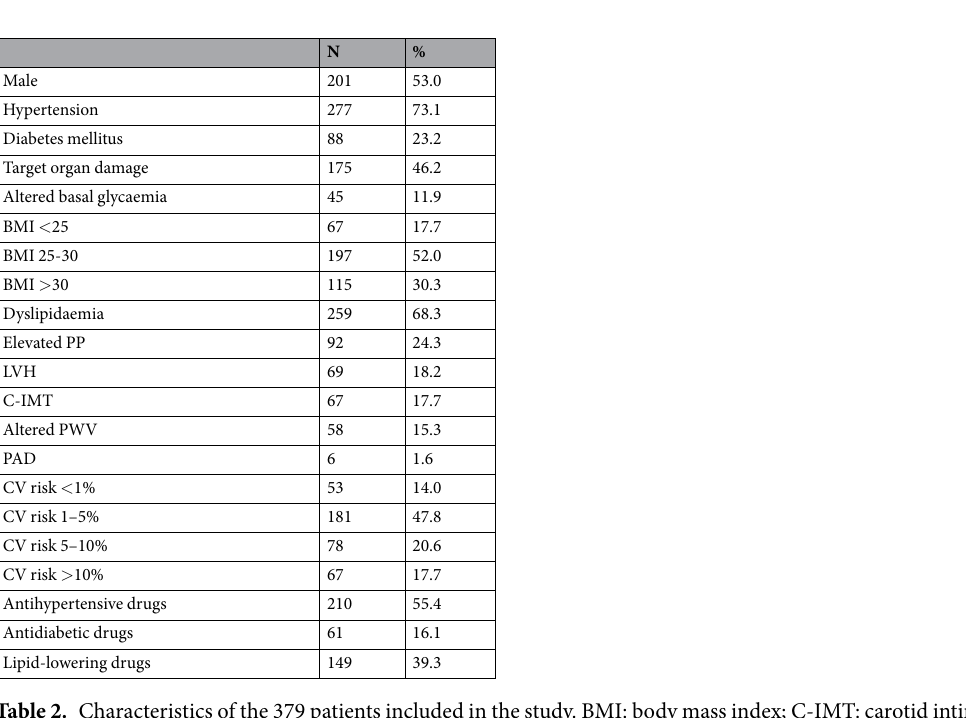
Table 2. Characteristics of the 379 patients included in the study. BMI: body mass index; C-IMT: carotid intima media thickness; CV: cardiovascular; HT: hypertension; LVH: left ventricular hypertrophy; PAD: peripheral arterial disease; PP: pulse pressure; PWV: pulse wave